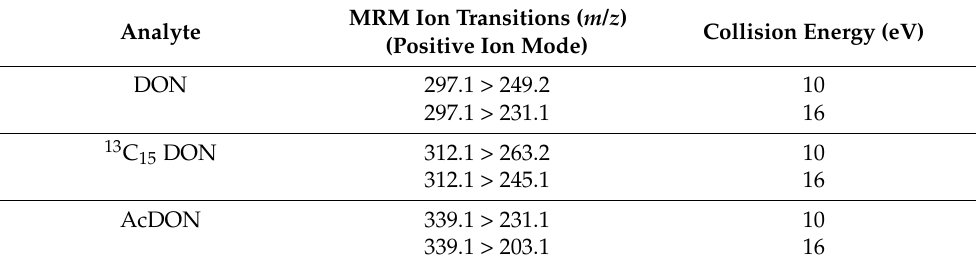
Table 1. MRM ion transitions for DON, 13 C 15 DON, and AcDON in triple quadrupole MS/MS and respective optimized collision